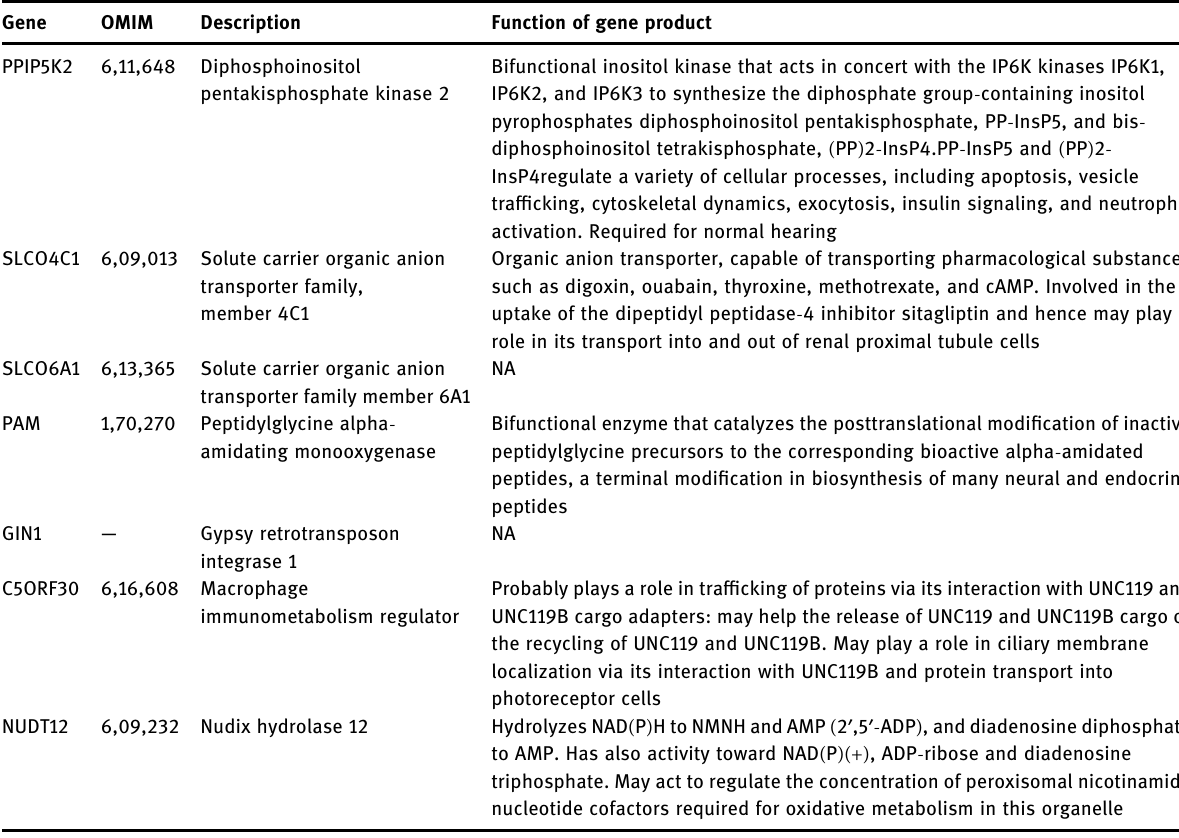
Table 1: Genes and gene product functions in the region of 5q21.2q21.3 ( 101116629 – 105838444 )